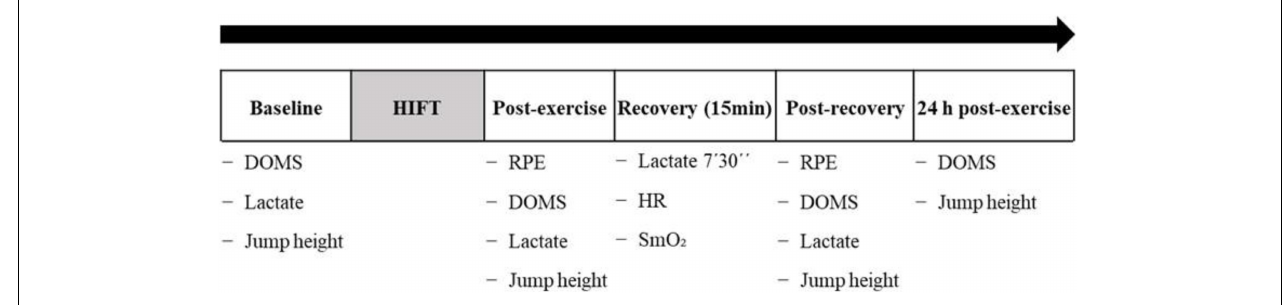
FIGURE 1 | Schematic figure representing the experimental protocol. Abbreviations: DOMS, delayed-onset muscle soreness; HR, heart rate; RPE, rating of perceived exertion; SmO 2 , muscle oxygen